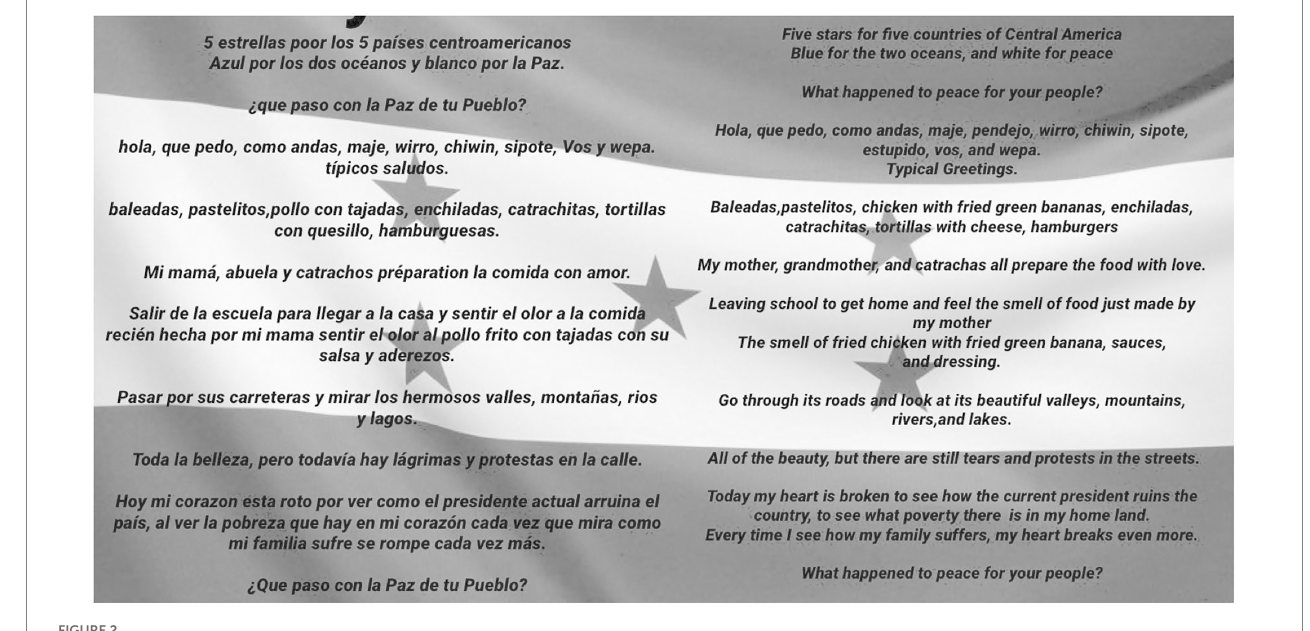
FIGURE 2 Honduras poem.